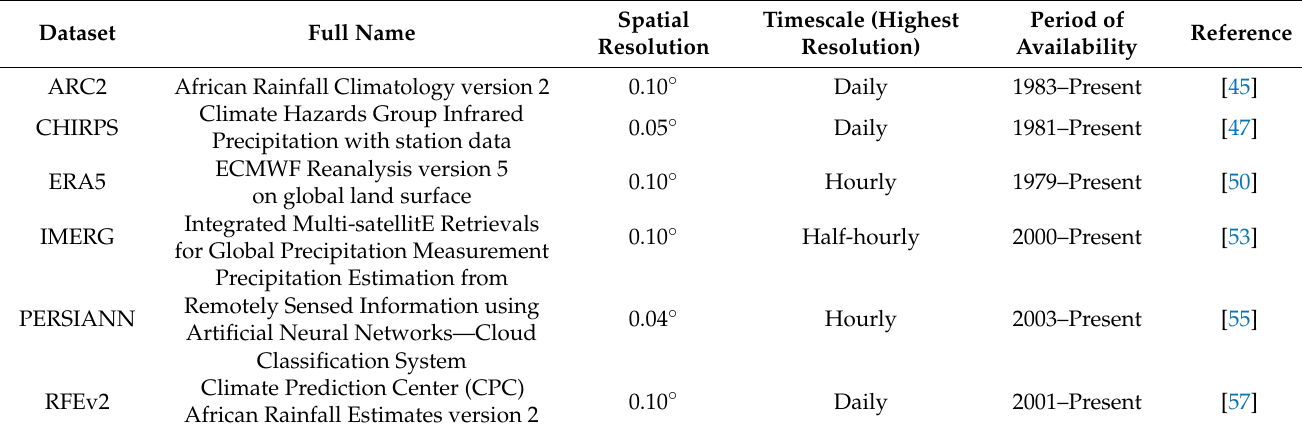
Table 1. Selected gridded precipitation